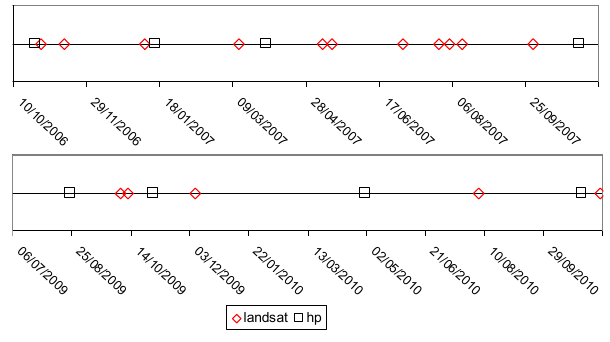
Figure 2. Temporal distribution of high precision and Landsat shorelines during the defined periods: 2006-2007 and 2009-